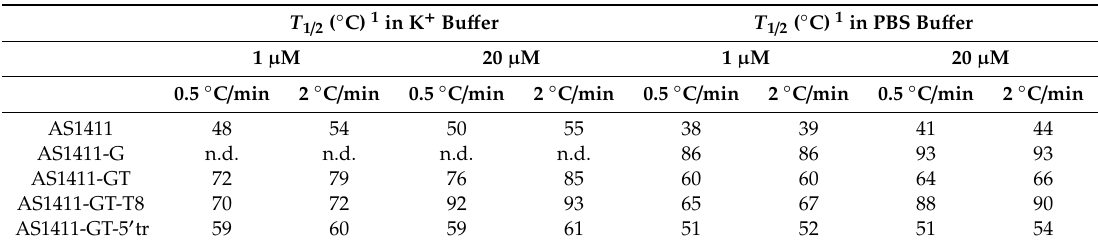
Table 2. Apparent melting temperatures ( T 1 / 2 ) of GROs in K + and PBS bu ff ers at di ff erent DNA concentration and heating rate determined by circular dichroism (CD) melting curves.